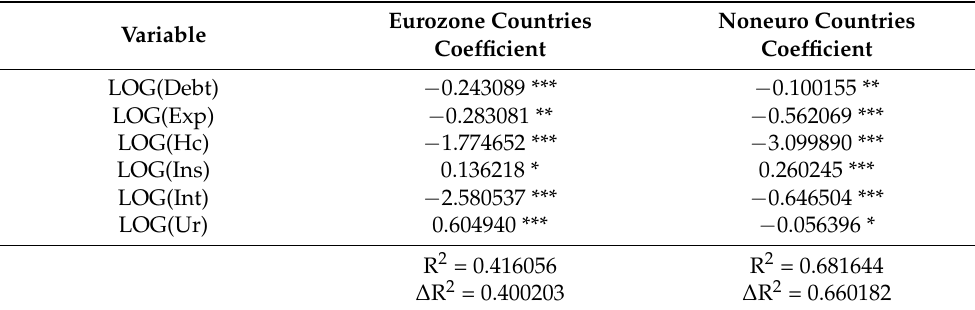
Table 12. Outcomes after the